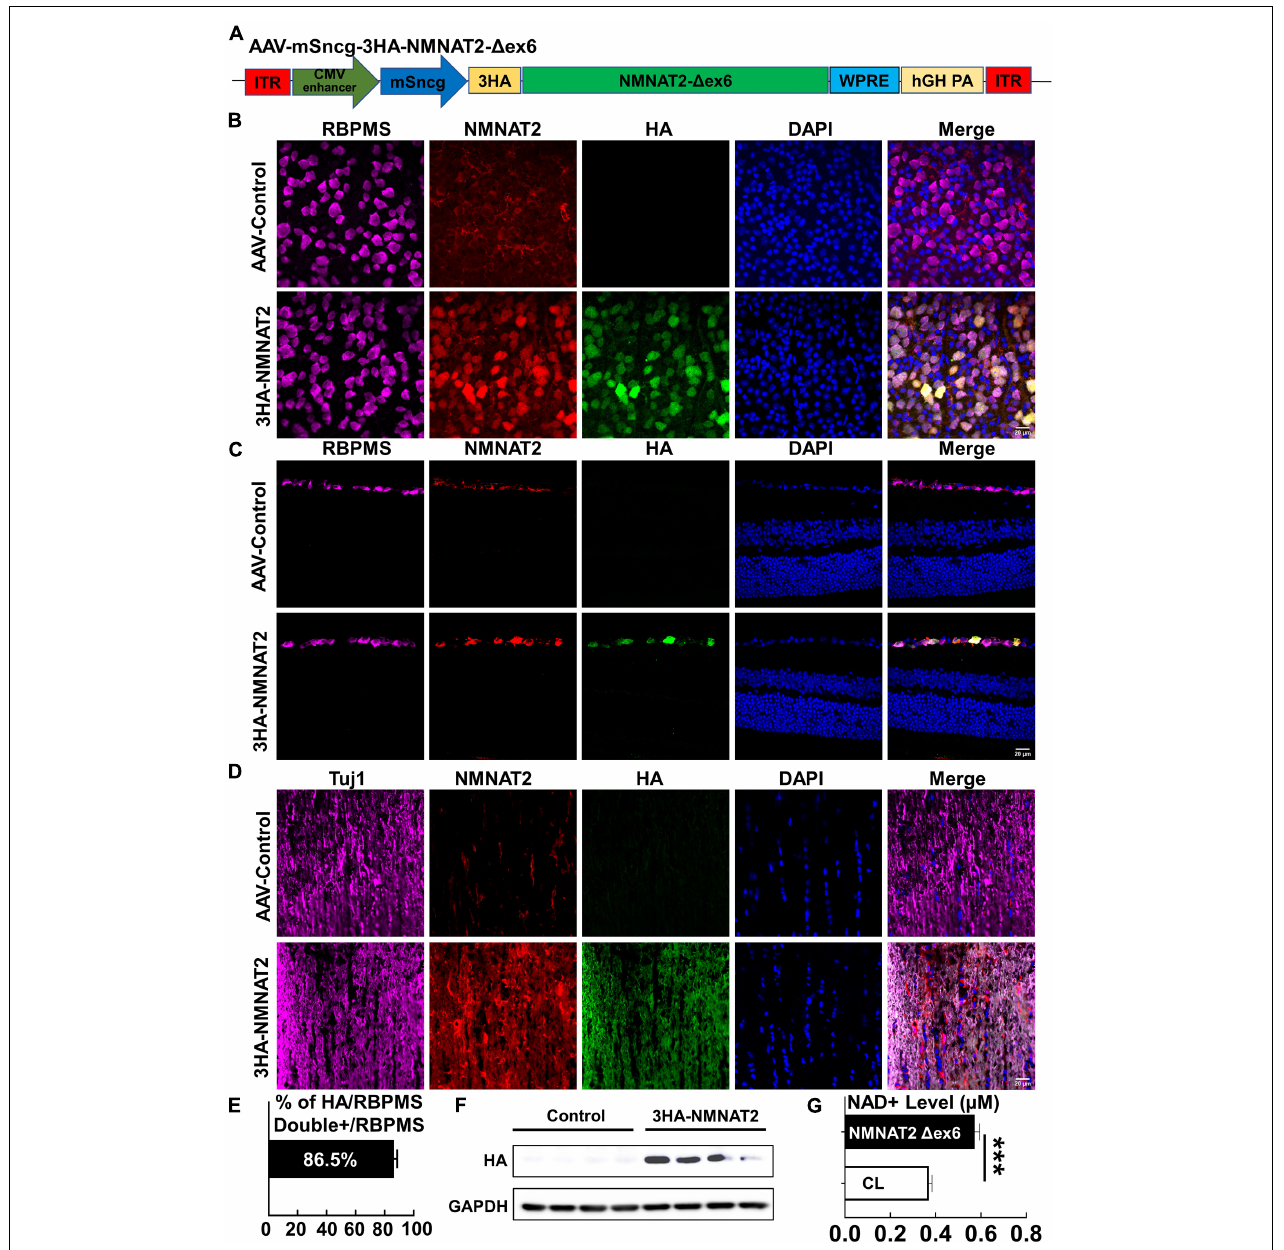
FIGURE 1 | AAV2-mSncg-mediated retinal ganglion cell (RGC)-specific expression of NMNAT2 (cid:49) ex6 in vivo . (A) Schematic diagram of AAV vector containing mSncg promoter-driven 3HA-NMNAT2 (cid:49) ex6. (B) Confocal images of flat-mounted retinas showing RBPMS-positive RGCs and HA-tagged NMNAT2 expression in mice 2 weeks after intravitreal injection of AAV2-mSncg-3HA-NMNAT2 (cid:49) ex6, but not in mice injected with the control AAV2. Scale bar, 20 µ m. n = 4. (C) Confocal images of the retina cross sections showing HA-tagged NMNAT2 expression in RBPMS-positive RGCs but not in the other layers of the retina, 2 weeks after intravitreal injection. Scale bar, 20 µ m. n = 3. (D) Confocal images of optic nerve (ON) longitudinal sections showing HA-tagged NMNAT2 expression in the ONs 2 weeks after intravitreal injection. Scale bar, 20 µ m. n = 3. (E) Quantification of HA/RBPMS-double positive cells in wholemount retinas. Data are presented as means ± SEM, n = 4. (F) Western blot analysis showing HA-tagged NMNAT2 expression in the ONs 2 weeks after AAV intravitreal injection. N = 4. (G) NAD + levels in the ONs with or without NMNAT2 overexpression 2 weeks after intravitreal injection. Data are presented as means ± SEM, n = 3. *** p < 0.001.